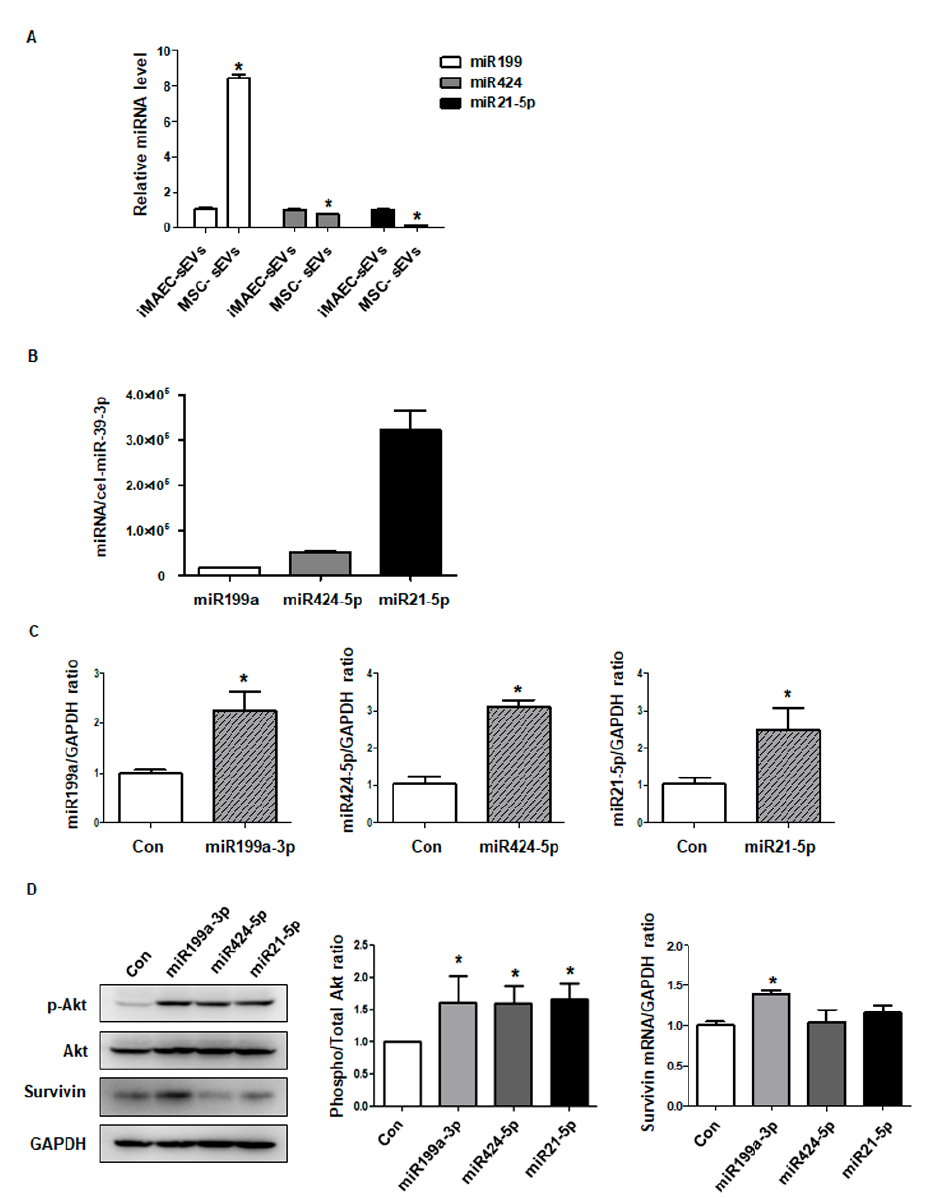
Figure 5. MiRNAs in MSC-sEVs contribute to the Akt/survivin pathway in cardiomyocytes. ( A ) The levels of miR199a − 3p, miR424 − 5p and miR21 − 5p in both iMAEC − sEVs and MSC − sEVs were measured with qPCR. The miRNA levels of MSC − sEVs are indicated relative to those of the iMAEC − sEVs ( n = 5). * Significant difference compared to the iMAEC − sEVss ( p < 0.05). ( B ) The levels of three miRNAs (miR199a − 3p, miR424 − 5p, and miR 21 − 5p) in MSC − sEVs were measured by qPCR ( n = 5). Synthetic Caenorhabditis elegans miRNA, cel − miR − 39 was spiked into each sample as an internal control. ( C ) For overexpression of three miRNAs (miR199a − 3p, miR424 − 5p, and miR 21 − 5p), H9c2 cells were transfected with three individual miRNA mimics. The levels of three miRNAs were measured with qPCR ( n = 5). * Significant difference compared to the control ( p < 0.05). ( D ) H9c2 cells transfected with three independent miRNAs (miR199a − 3p, miR424 − 5p, and miR 21 − 5p) were harvested. The protein levels of p − Akt, Akt, survivin, and GAPDH were measured by Western blotting ( n = 5). * Significant difference compared to the control ( p < 0.05).